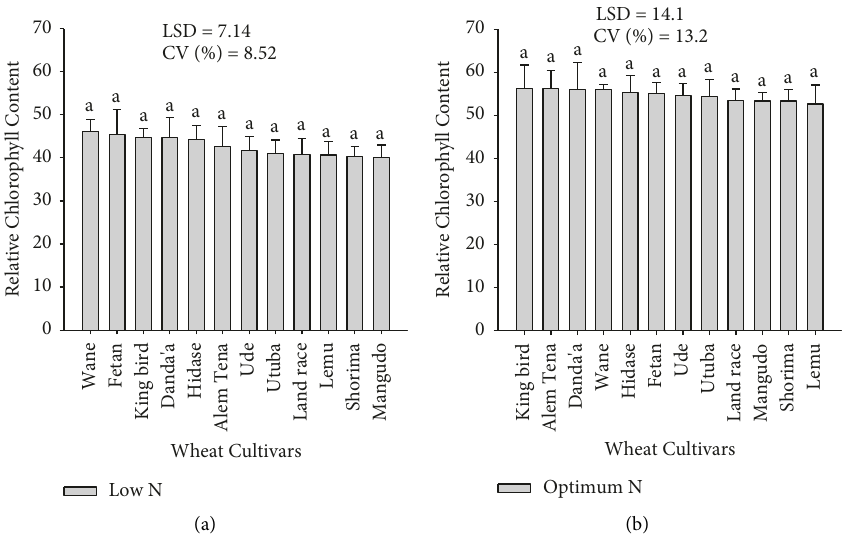
Figure 1: Relative chlorophyll content of wheat cultivars under low and optimum N supply. Bars followed by similar letters under similar N level are not significantly different from each other at 5% probability level.